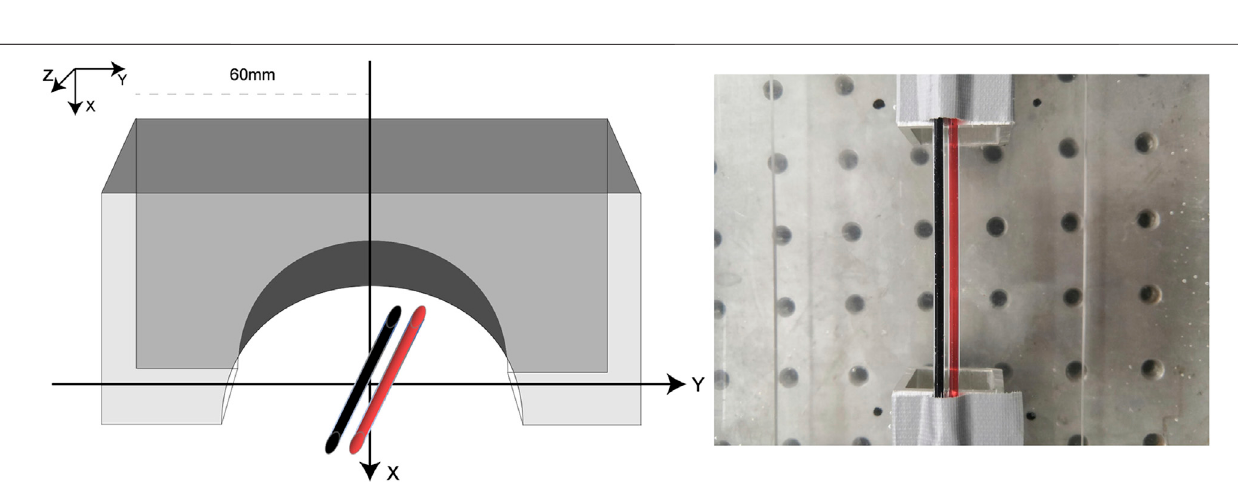
Frontiers in Materials |